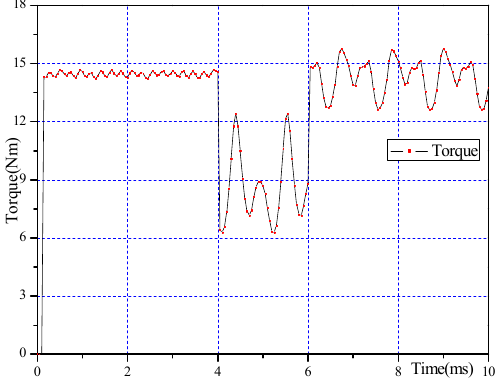
Figure 33. The co ‐ simulation electromagnetic torque when the open ‐ circuit fault occurs in phase “a” of outer motor and phases “b” and “e” of inner motor in parallel drive mode (open circuit fault point: 4 ms; injecting the fault current point: 6 ms).